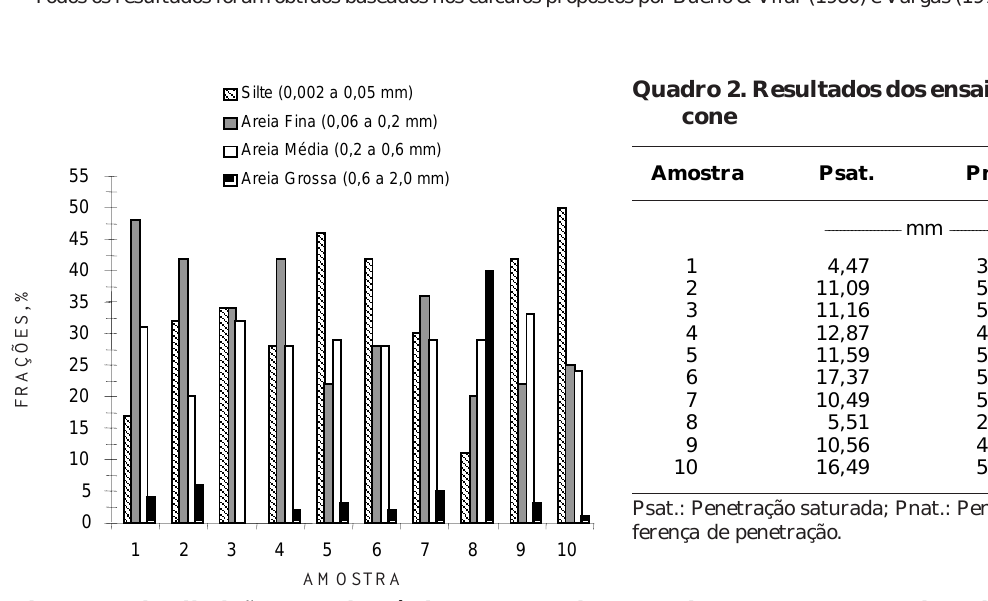
Figura 3. Distribuição granulométrica sem uso de